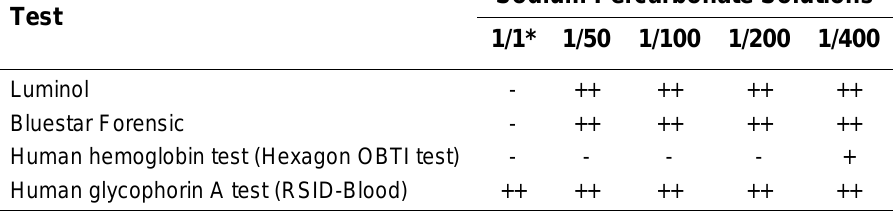
Results of the Luminol, Bluestar Forensic, Human Hemoglobin, and Human Glycophorin A Tests on Bloodstains Washed in Water at 40ºC, with Sodium Percarbonate to Different Concentrations (A Samples)